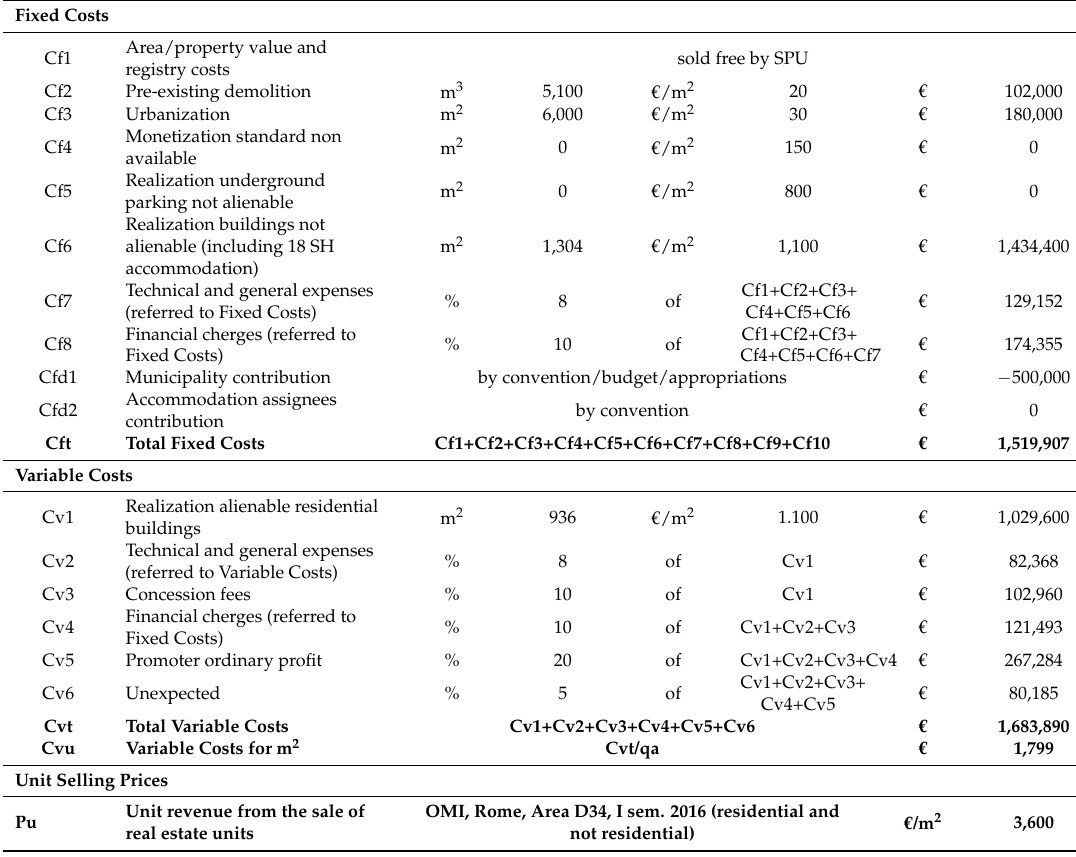
Table 1. BEA for intervention in Via Grotta Perfetta